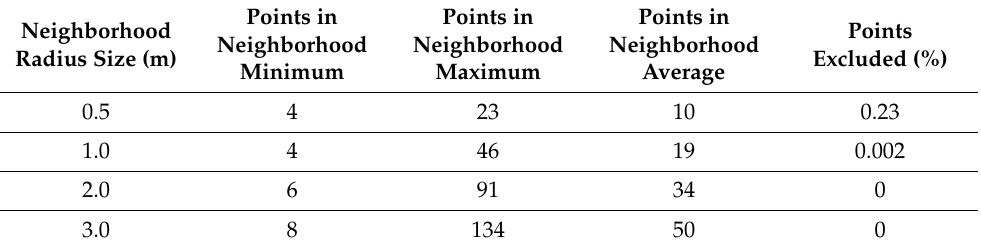
Table 3. Orthophoto